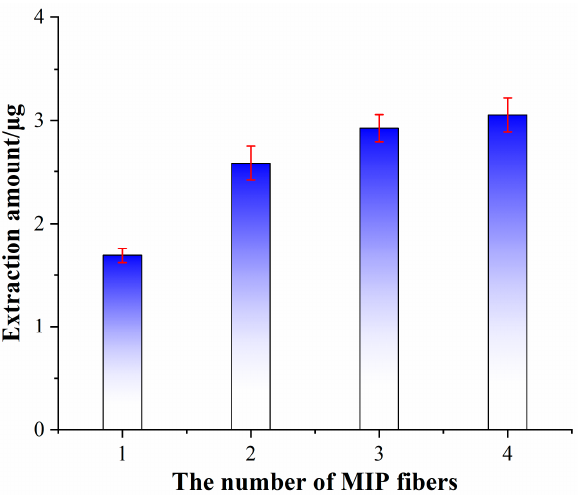
Figure 10. Effect of the number of MIP fibers on the extraction amounts.